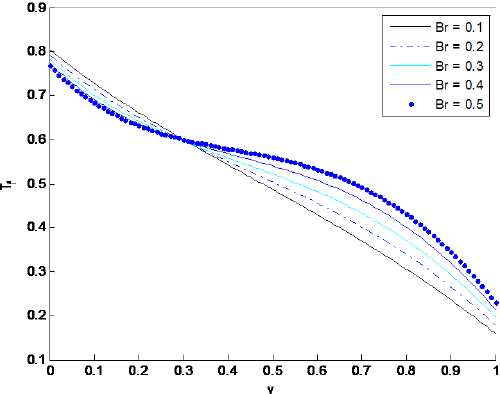
Figure 3: Temperature profile for different values of Brinkman num-